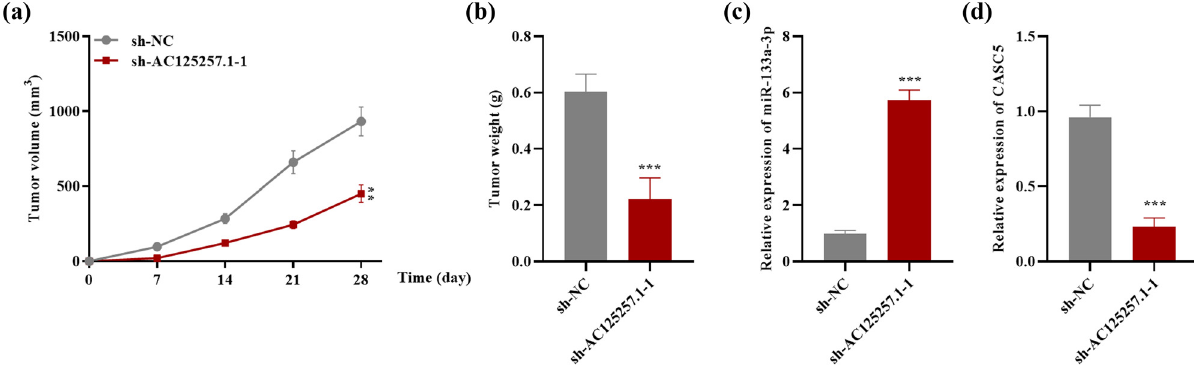
Figure 6: ( a ) Tumor volume in each group was measured on days 7, 14, 21, and 28. ( b ) Mouse tumor weight in the sh - NC and sh - AC125257.1 - 1 groups. ( c ) RT - qPCR was used to detect the expression of miR - 133a - 3p in mouse tumor tissues in each group. ( d ) The expression of CASC5 was measured using RT - qPCR mouse tumor tissues in each group. ** P < 0.01, *** P <